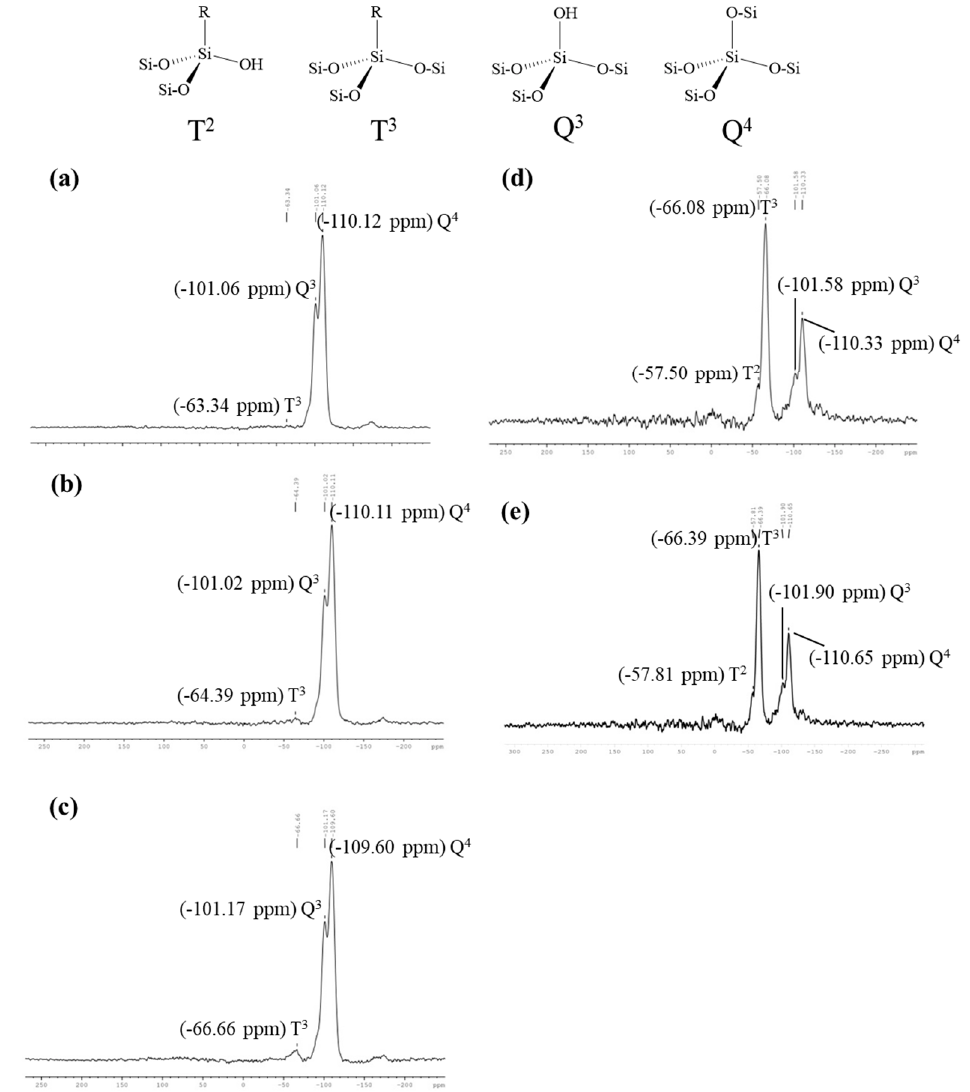
Figure 2. Solid-state 29Si-NMR spectra of the hydrophilic ( a ) A1, ( b ) A2, and ( c ) A3 MSPs, as well as the hydrophobic ( d ) M1 and ( e ) M2 MSPs.